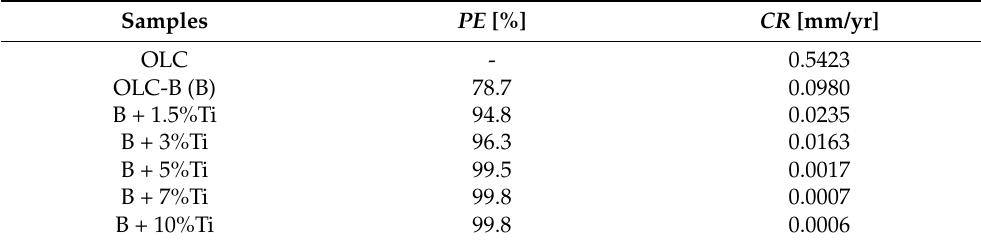
Table 3. Protection efficiency ( PE ) and corrosion rates ( CR ) for mild steel and NiCr(Ti) coatings on